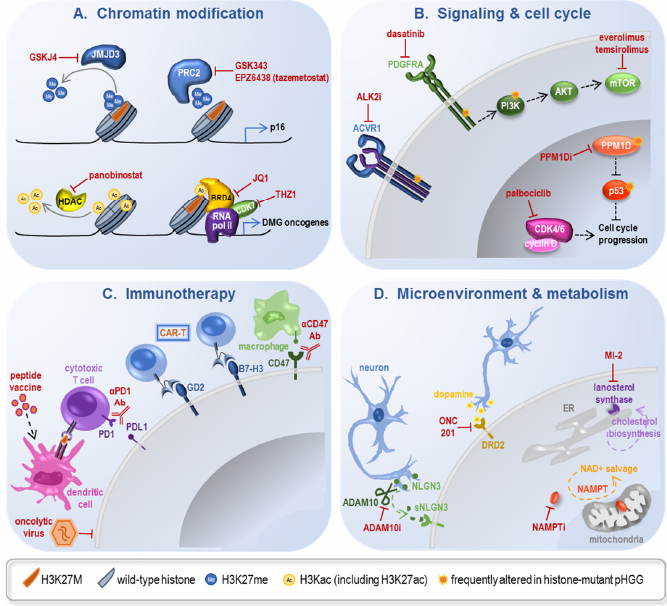
Figure 3. Strategies for molecular intervention in oncohistone-driven pHGG. Ac: acetylation; ER: endoplasmic reticulum; Me: methylation; RNA pol II: RNA polymerase II. See text for other abbreviations common to multiple tables and figures.